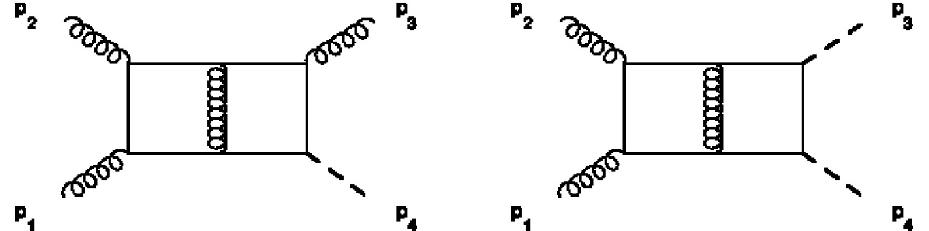
Figure 14. A planar contribution to H + j (left) and to HH